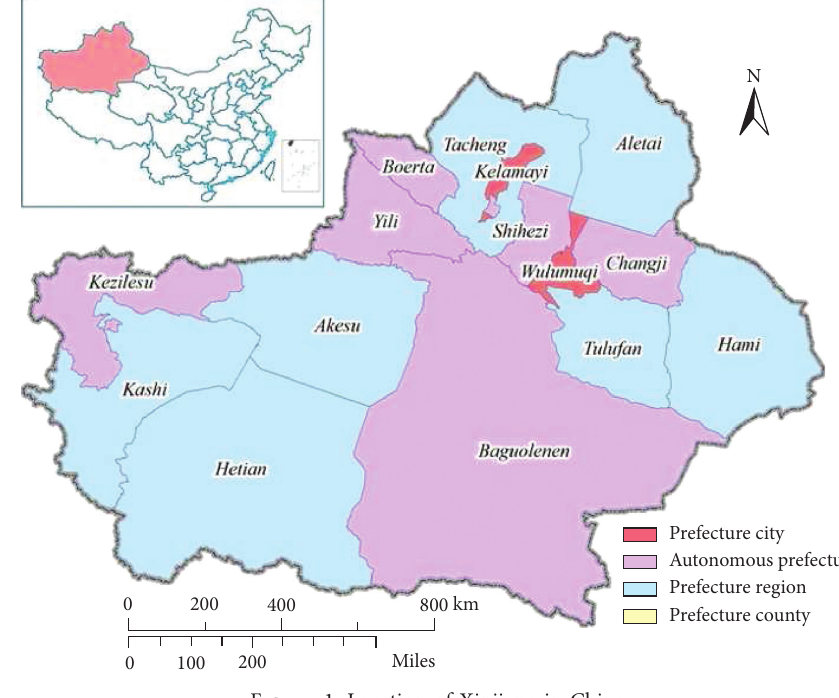
Figure 1: Location of Xinjiang in Table 1: Major development indicators of Xinjiang, 2018.